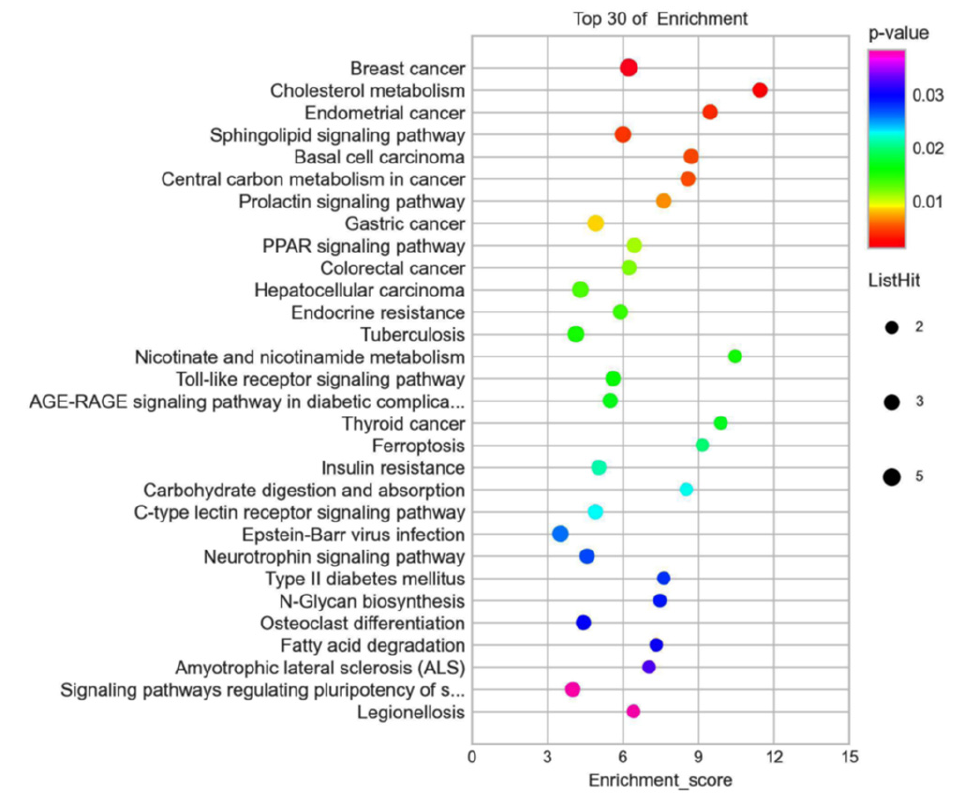
Figure 7. KEGG analyzed the 72 different expression genes. KEGG analysis consists of signal pathways and molecular function. The vertical items are the names of GO terms, and the length of horizontal graph represents the adjusted p -value. The depth of the color represents the − log(10) adjusted p -value. These analyses using software of g: Profiler and Cytoscape 2.8.2 software.